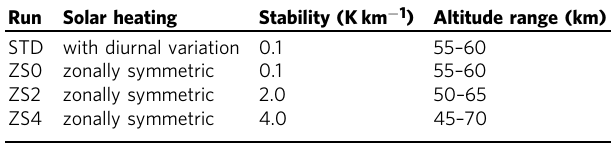
The right two columns show the static stability and the altitude range of the low-stability layer giveninthebasictemperaturepro fi leforNewtoniancoolingshownbydashedlinesinFig.3.See Methods for the details of the solar heating and the low-stability